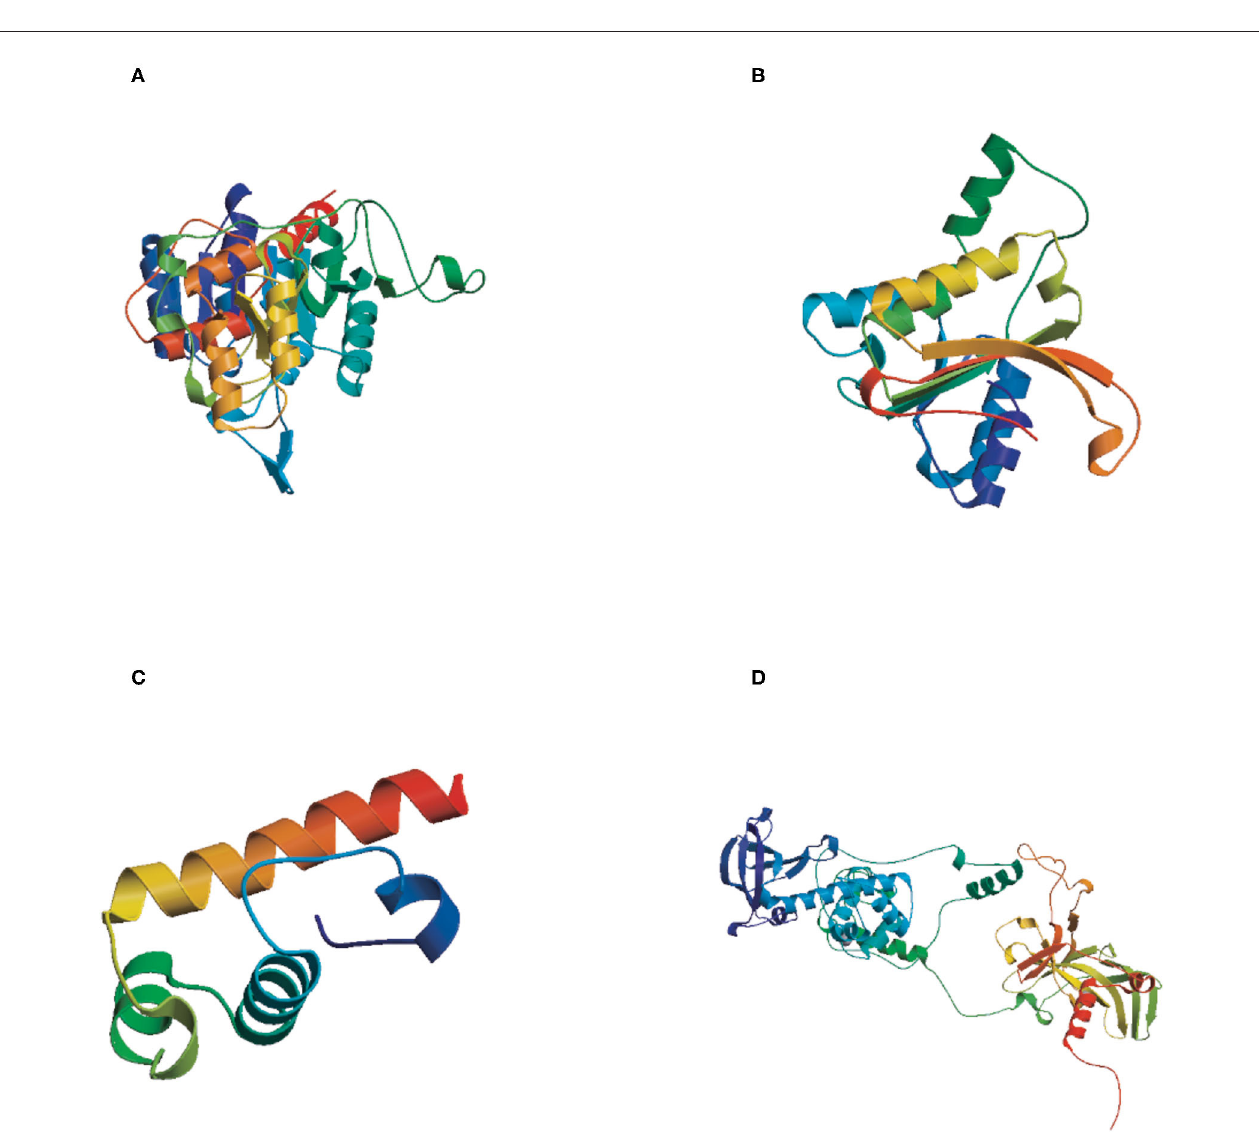
FIGURE 3 | The tertiary structure (3D) of putative DNA methyltransferase proteins predicted by Swiss-Model. (A) DsDnmt, GMQE value = 0.65; (B) DsDnmt1, GMQE value = 0.79; (C) HlDnmt1, GMQE value = 0.10; (D) HlDnmt, GMQE value =